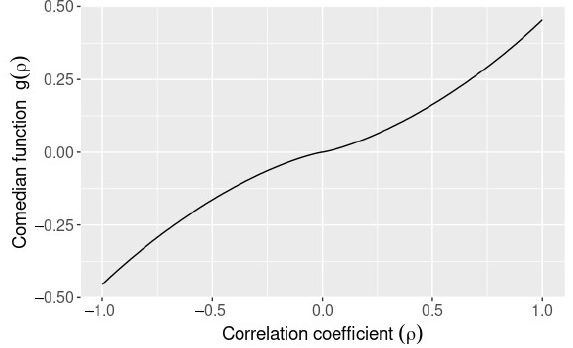
Figure 1. Approximation obtained by simulations of the comedian g ( (cid:36) ) = COM ( X , Y ) as a function of the correlation coefficient (cid:36) , where g ( 1 ) = ( Φ − 1 ( 0.75 )) 2 . Source: the